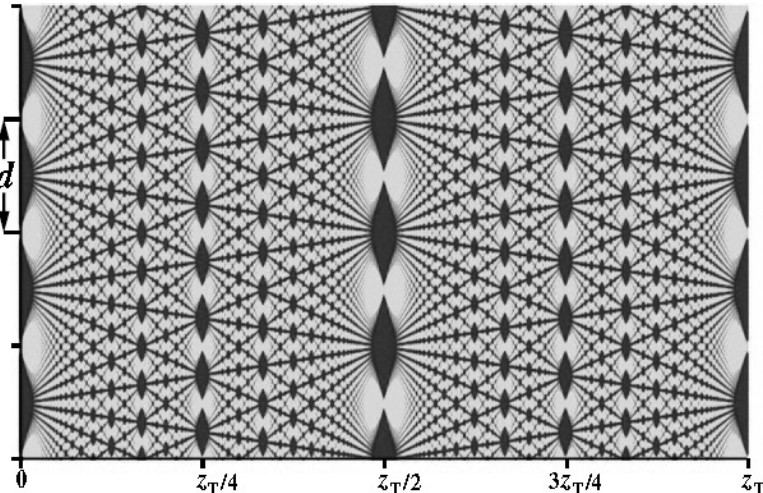
Figure 17. The density distribution p ( z , x ) = (cid:104) ψ ( z , x ) | ψ ( z , x ) (cid:105) taken from central part of the in- terference grating shows the Talbot carpet at choosing N = 64 (cid:29) 1 of slits. The central slits are n = 30,31,32,33,34. Here z T = d 2 / λ dB is a unit of length named the Talbot length.